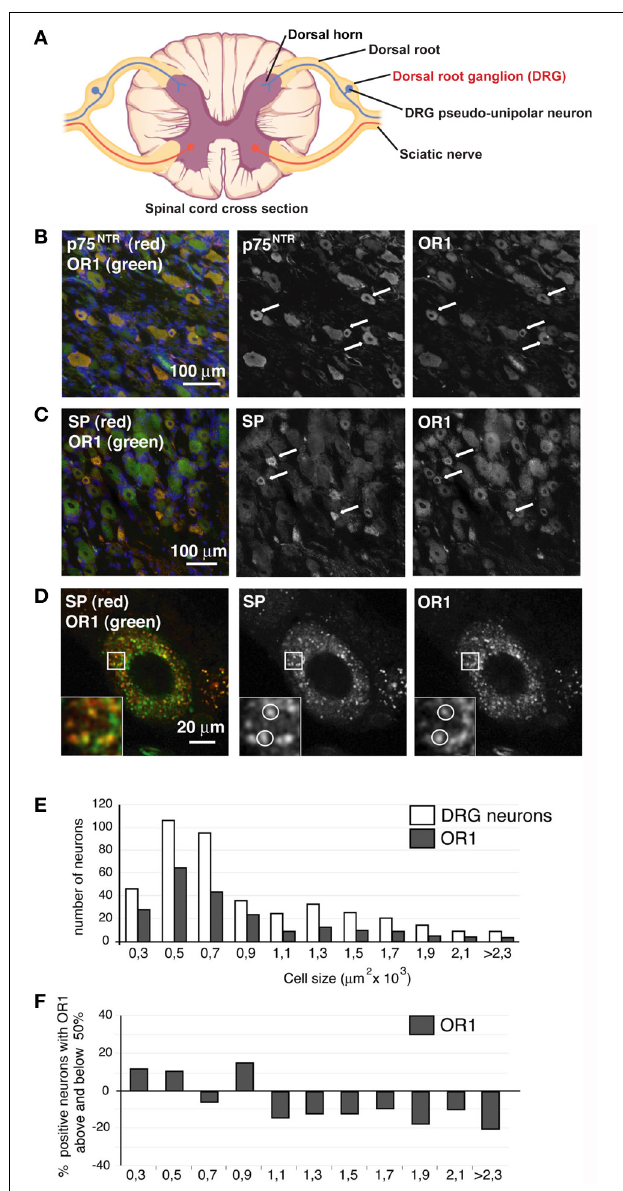
FIGURE 2 | OR1 is present in DRG neurons. (A) Scheme. DRG, site of analyses presented below, is indicated in red. (B) DRG neurons stained for p75 NTR (red) and OR1 (green), nuclei were stained in blue with DAPI. Most p75 NTR neurons were OR1 positive (arrows). (C) DRG neurons stained for SP (red) and OR1 (green). All SP positive neurons were strongly positive for OR1. (D) SP (red) and OR1 (green) showed a punctuated pattern as well as a clear colocalization in a third of SP puncta. (E) Size distribution of OR1 in DRGs compared to the size distribution of all DRG neurons. (F) Percentage of DRG neurons of a given size positive for OR1 (the numbers are given as percentage above and below 50%; baseline 0 corresponds to 50% of neurons positive for OR1). Arrows and white circles denote